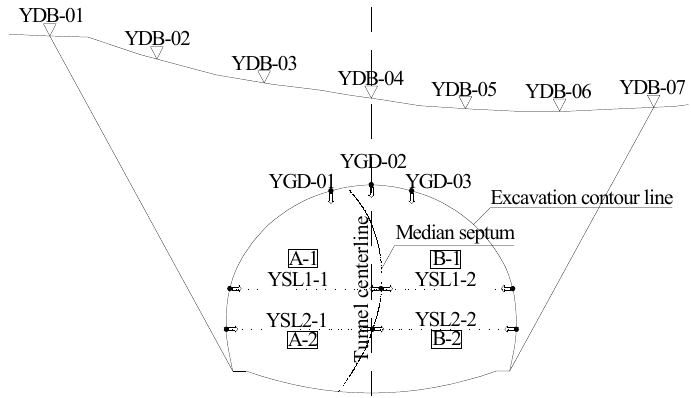
Figure 8. Locations of deformation test points.